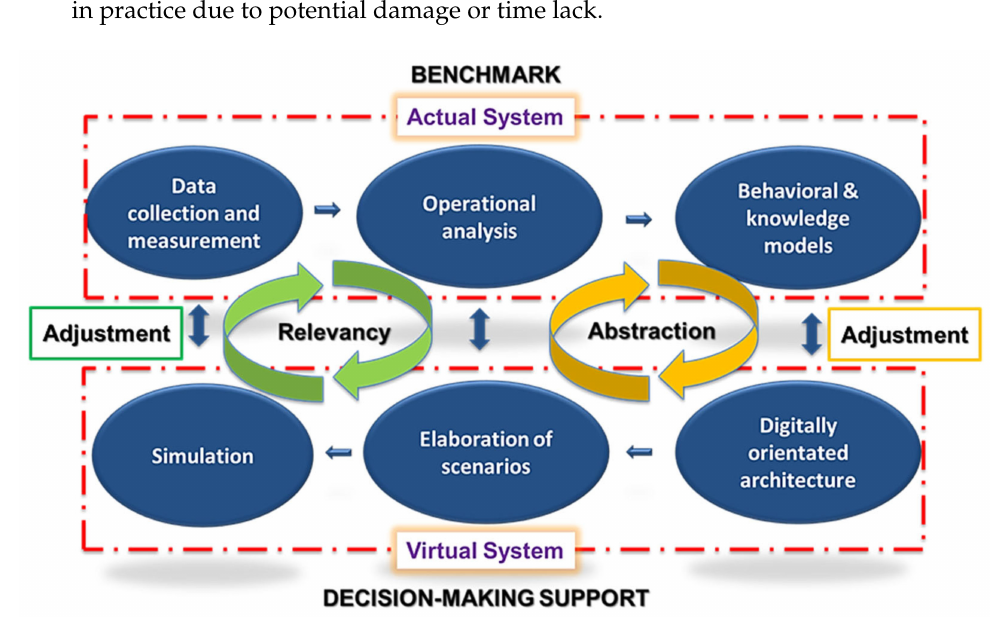
Figure 14. Graph of general approach to data analysis and system